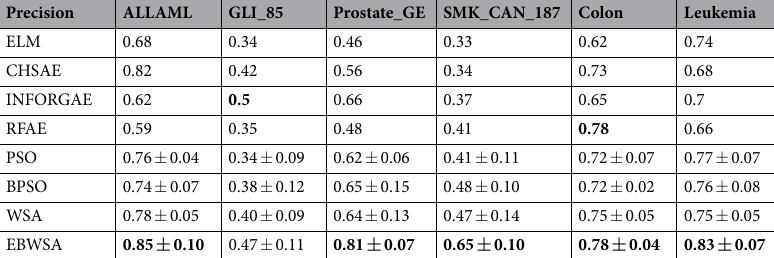
Table 4. Precision of all datasets with different methods (best results highlighted in bold).